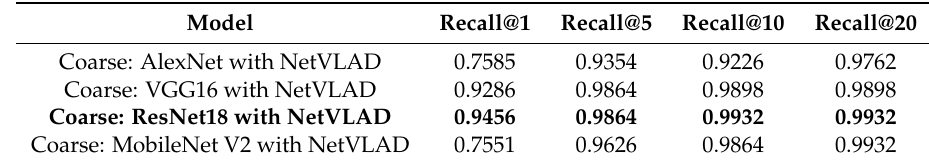
Table 2. Localization results of coarse stage on the Pitt250 val subset.